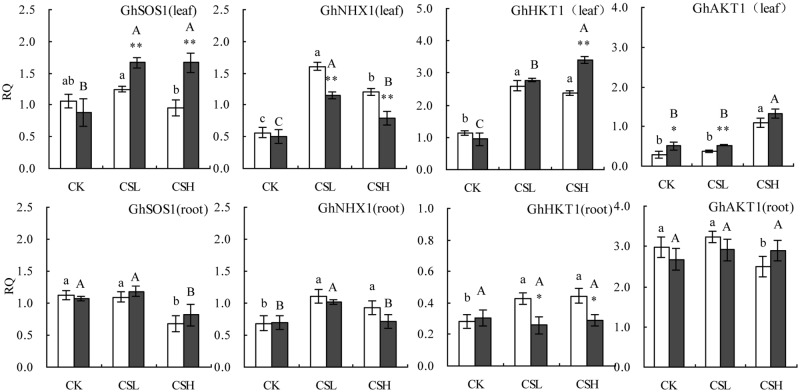
Relative expression of GhSOS1, GhNHX1, GhHKT1, and GhAKT1 genes of cotton leaf and root under NaCl stresses.Symbols indicate L24 cultivar (white bar) and X45 cultivar (black bar). Vertical bars represent ± standard error (n = 3). Asterisks indicate a significant difference between L24 and X45 (*P<0.05; **P<0.01). Bars labeled with the different lowercase letters on open square bars or uppercase letters on closed square bars are significantly different (P<0.05).